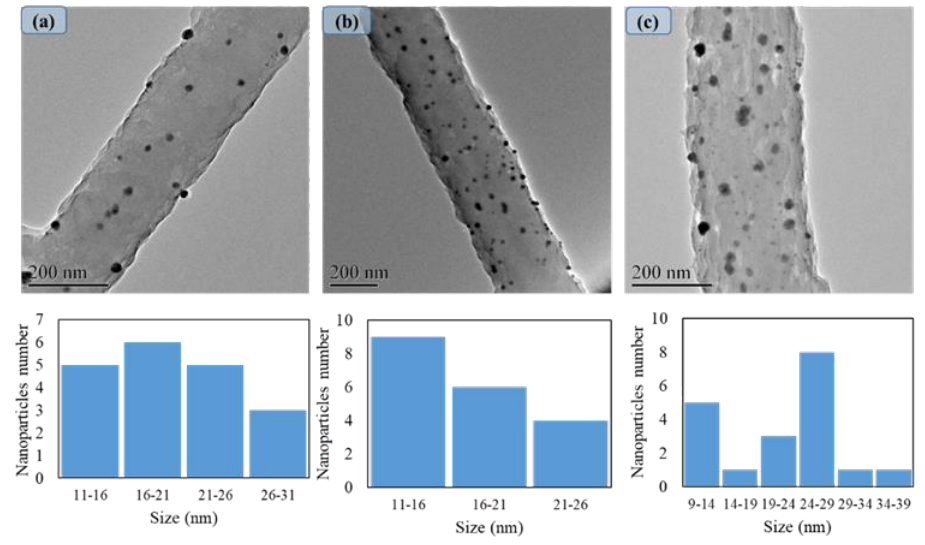
Figure 3. TEM images & size distributions of PAN/AgNPs nanofibers one cycle loaded: ( a ), PAN/AgNPs nanofibers two cycles loaded: ( b ), and PAN/AgNPs nanofibers three cycles loaded: ( c ).